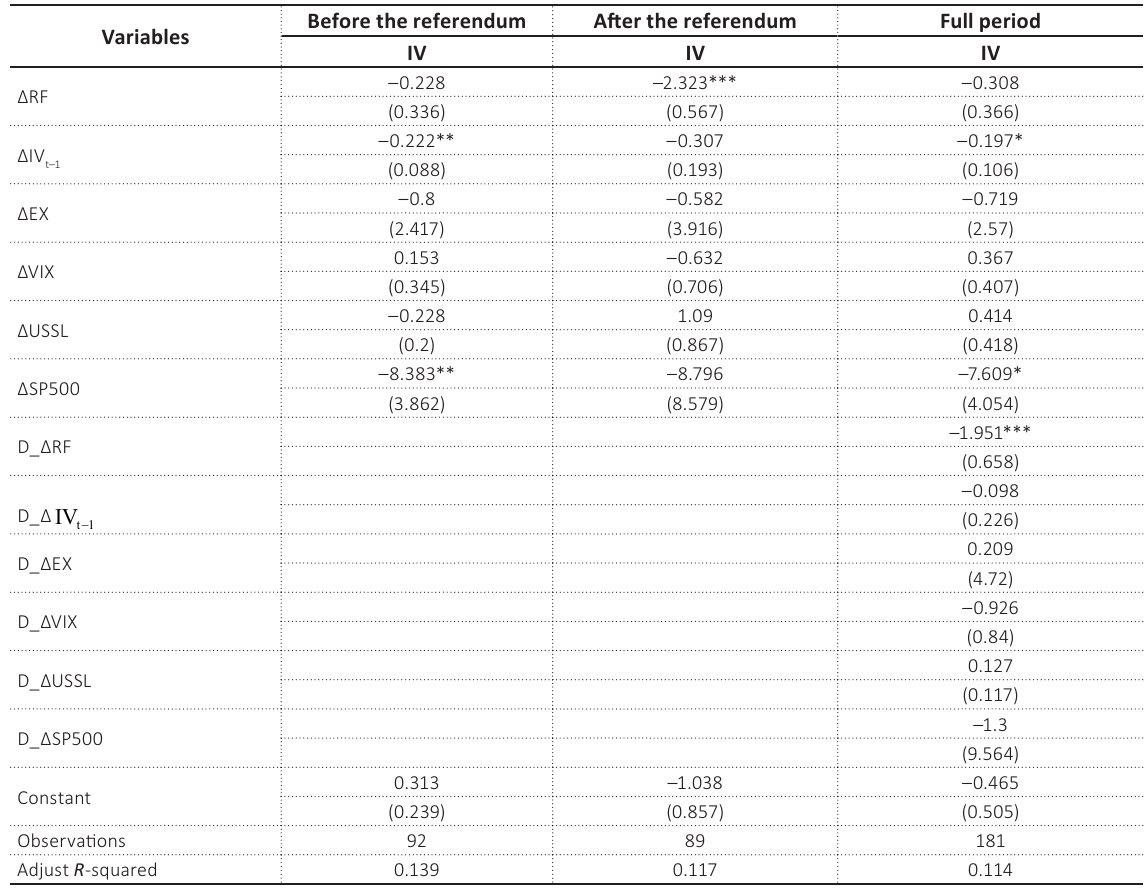
Table 2. Model estimation results